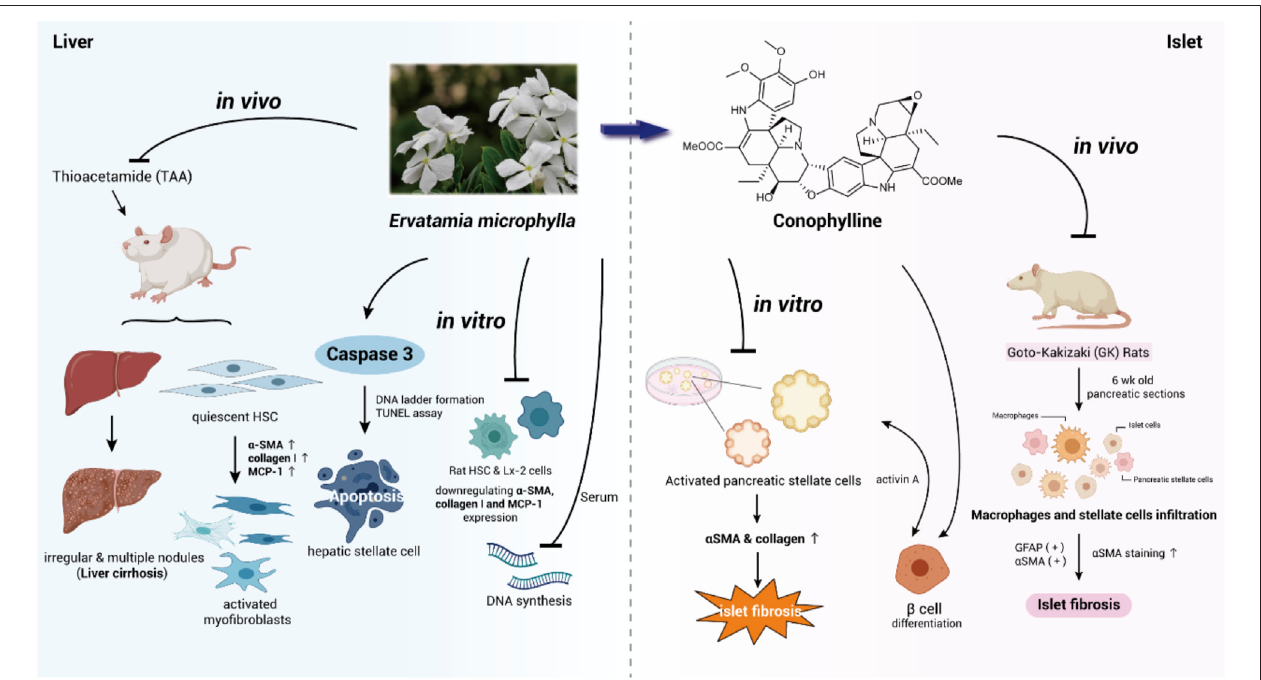
FIGURE 6 | Conophylline inhibits activation of stellate cells to attenuate liver fi brosis and islet fi brosis.